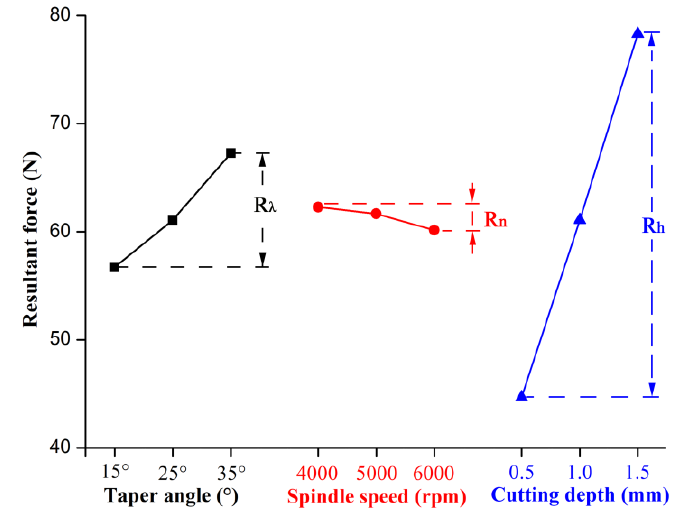
Figure 3. Trends of cutting force under different cutting conditions.